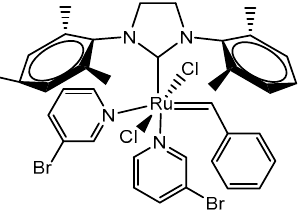
Figure 5. Milestones in the history of ROMP and molecular brush synthesis.